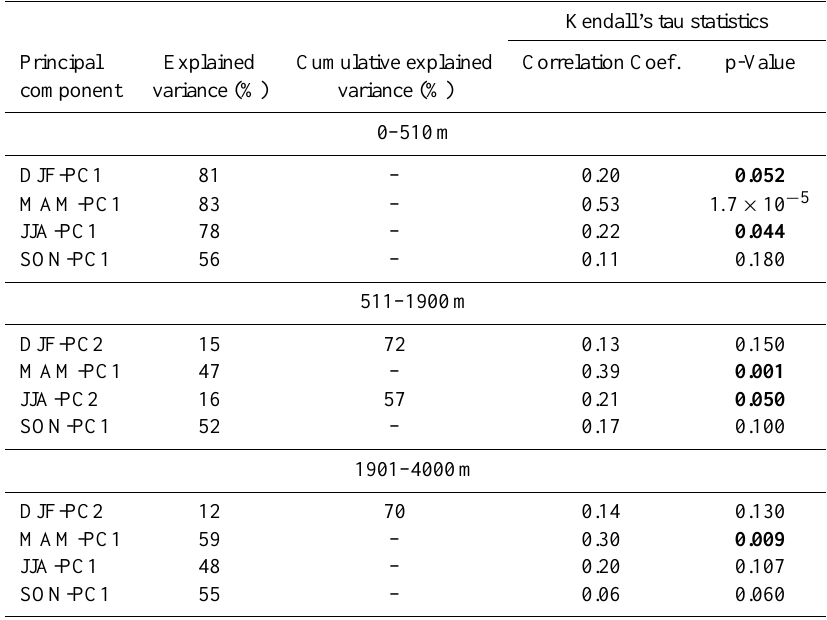
Table 1. Summary statistics of the PCA (explained and cumulative variance) of seasonal precipitation (DJF, MAM, JJA, SON). Kendall’s tau ( τ) statistics for test of correlation between PC scores and seasonal SSTA 1.2